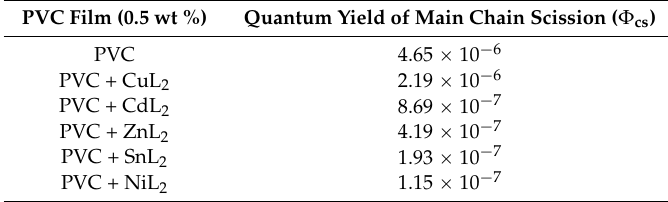
Table 1. The chain scission quantum yield ( Φ cs ) for PVC films after irradiation. a